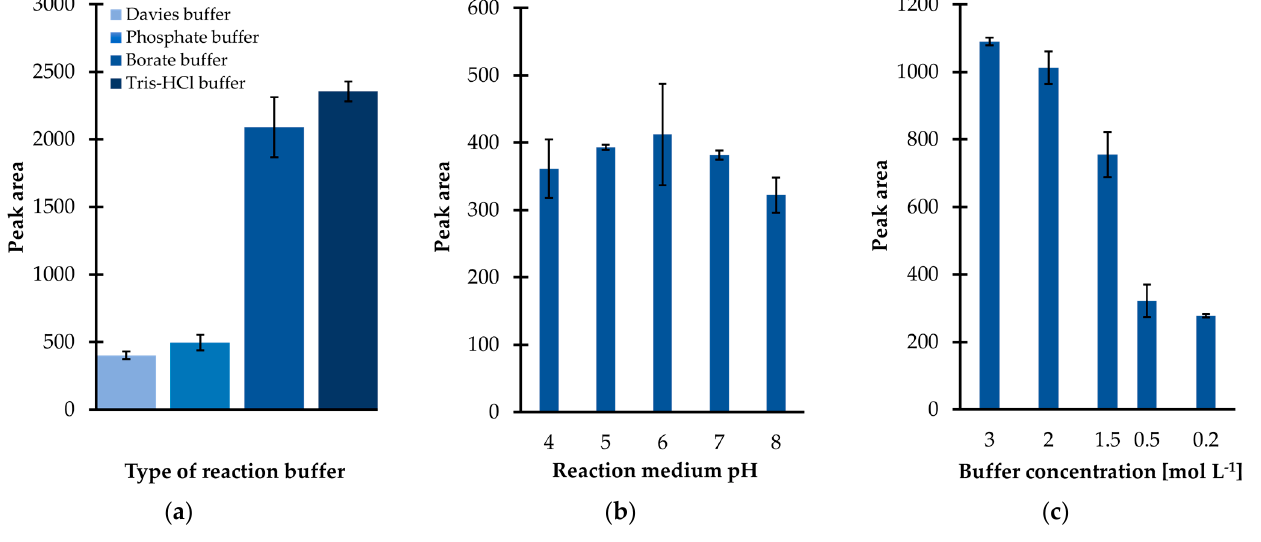
Figure 2. Derivatization reaction yield as a function of ( a ) the type of derivatization buffer; ( b ) pH of the reaction medium; ( c ) tris(hydroxymethyl)aminomethane-hydrochloride buffer (Tris-HCl) pH 7 concentration, expressed as the peak area of the isobutyl derivative of 1,3-thiazinane-4-carboxylic acid (TCA-IBCF). Samples were analyzed according to the procedure described in Section 3.6. Error bars refer to the standard deviation (SD) of the data ( n = 3). Abbreviations: Tris-HCl, tris(hydroxymethyl)aminomethane-hydrochloride acid buffer.